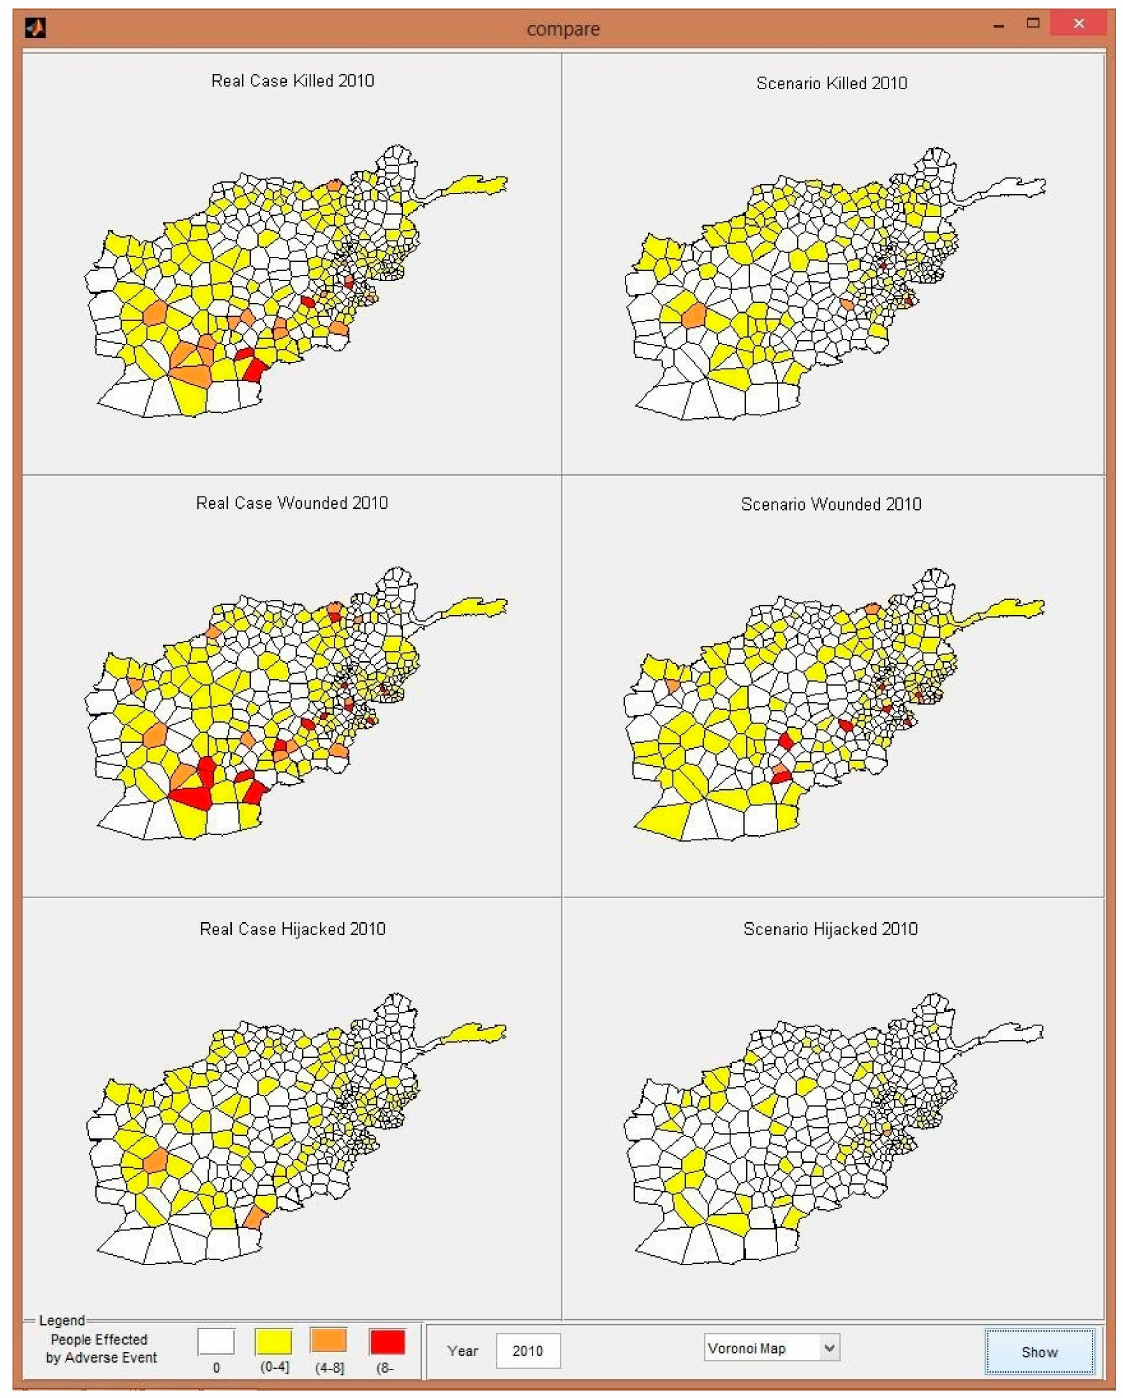
Figure 9. Real case and what-if scenario monthly average output for